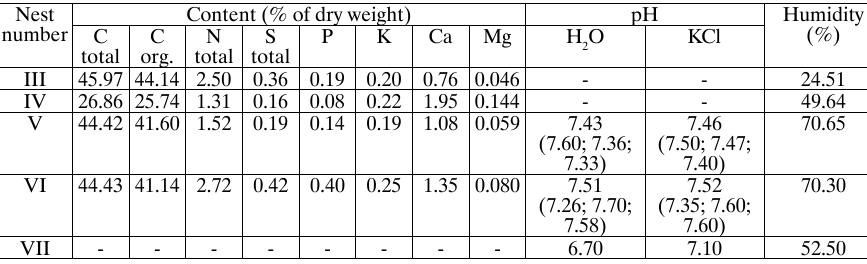
chemical content of Montagu’s Harrier ( Cyrcus pygargus ) nests Nest content (% of dry weight) number